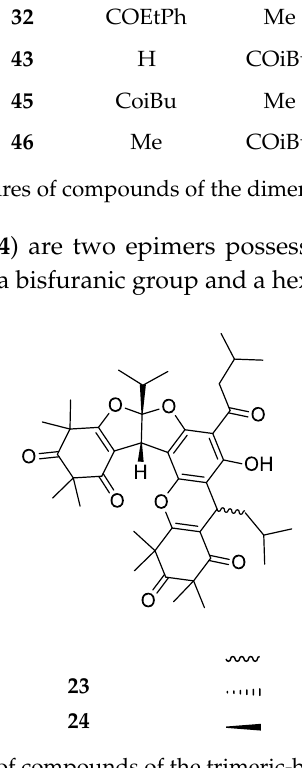
Figure 7. Structures of compounds of the trimeric-bisfurane-pyrane-type.